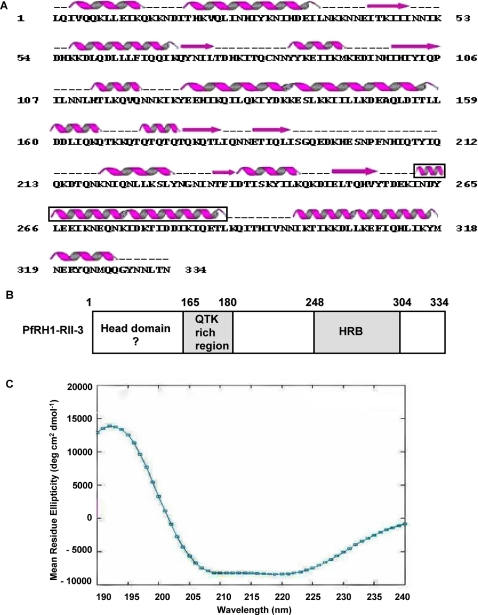
Bioinformatics and biophysical analysis of the minimal binding region RII-3 of PfRH1.(A) Secondary structure prediction of the putative erythrocyte binding region of PfRH1. The predicted secondary structure is shown above the sequence with α-helices as springs and β-strands shown as arrows. The region predicted to form a coiled-coil is boxed and includes residues 262 to 289. Dashed lines indicate regions with no secondary structure prediction. (B) Proposed topology for the RII-3 binding region. HRB indicates the Heptad repeat region which presents weak sequence identity with the parainfluenza F protein heptad repeat B that forms a coiled coil of three-helices. (C) CD spectrum of purified recombinant rRII-3. The graphical output was from SELCON3 (Dichroweb server). The mean residue ellipticity is plotted on the Y axis in degrees cm2 dmol−1. A positive peak at 190 nm and a negative peak at 208 and 222 nm indicate the presence α-helical structures in the protein.